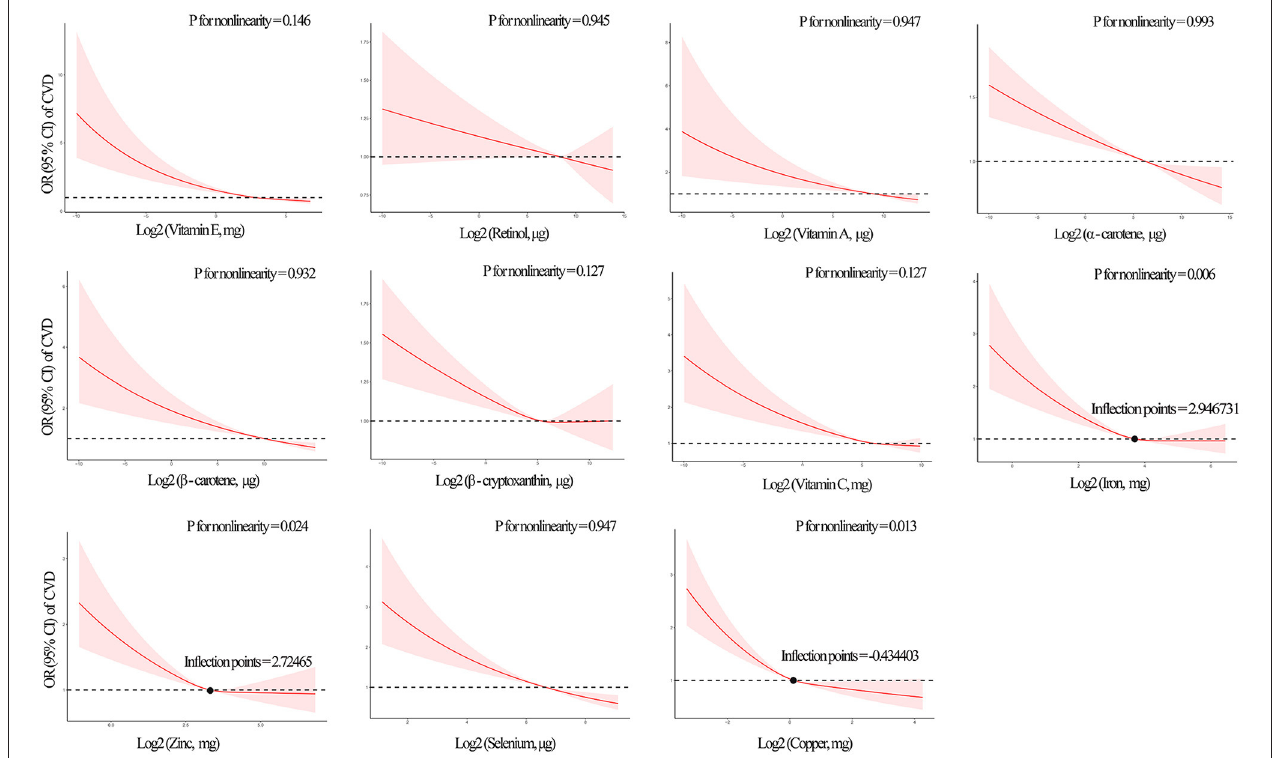
FIGURE 3 | Restricted cubic spline (RCS) analysis with a multivariate -adjusted association associations between dietary 11 antioxidant micronutrients and the prevalence of total CVD. Eleven specific antioxidant micronutrients index are modeled as restricted cubic splines with knots at the 10th, 50th, and 90th percentiles shown the non-linear association. Non-linearly related inflection points of iron, zinc and copper were annotated. The solid line is the adjusted HR; 10th percentile is used as the reference (HR = 1). The shaded area is the 95% CI of the HR. Iron, zinc and copper shown non-linearity association with total CVD model ( P for non-linearity <